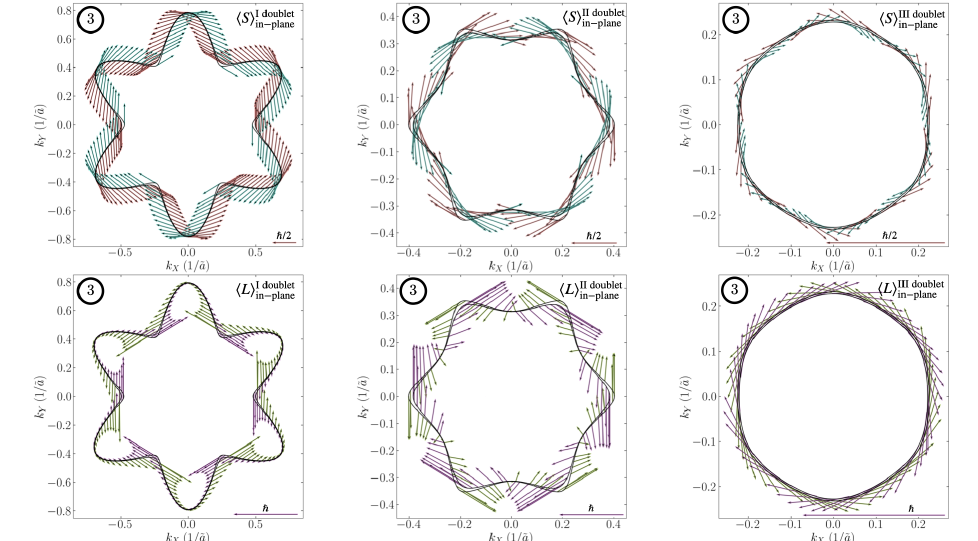
Figure 2. In-plane spin ( upper panel ) and orbital angular momentum ( lower panel ) textures for the three doublets with the chemical potential fixed to the value corresponding to the benchmark line 3 in Figure 1. The red and green arrows represent the mean value of the in-plane component of the operator for the external band, and the blue and purple refer to the internal component. The mean value of the generic operator O is evaluated as (cid:104) O (cid:105) =